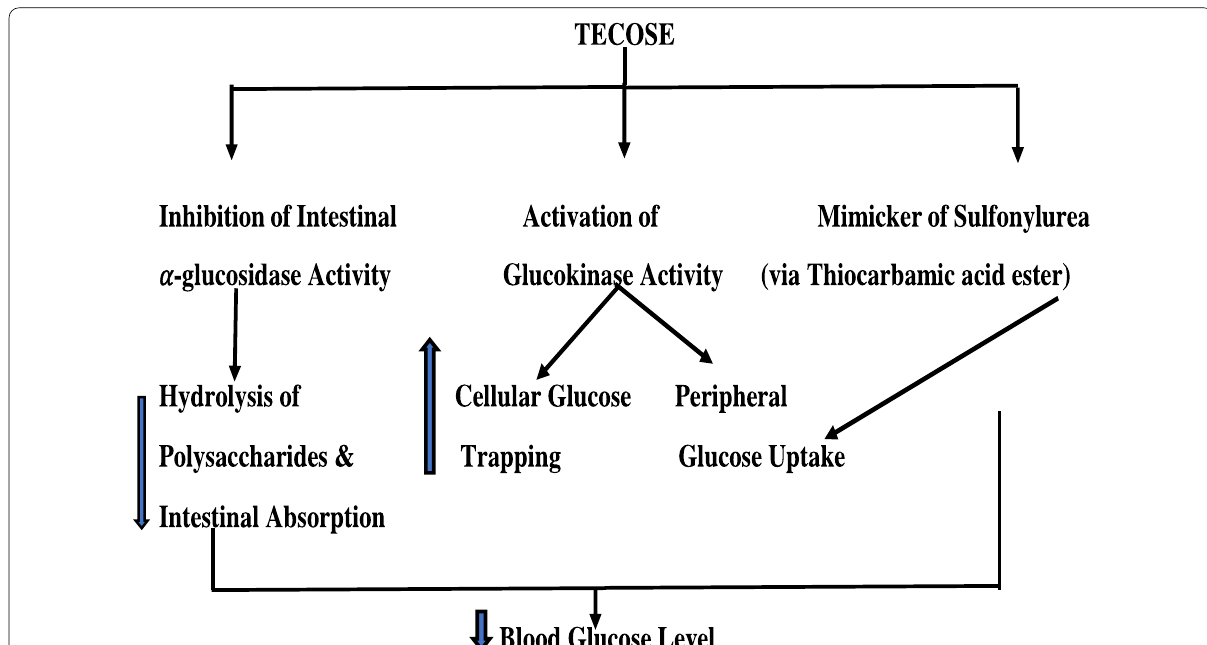
Fig. 10 Proposed mode of antihyperglycemic action of Tetracapidium conophorum seed